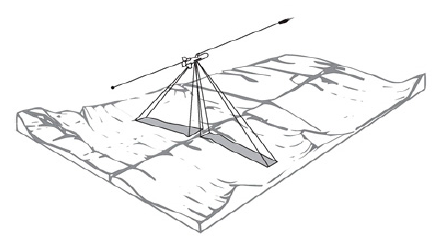
Figure 1. Working schematic diagram of a side-scan sonar.